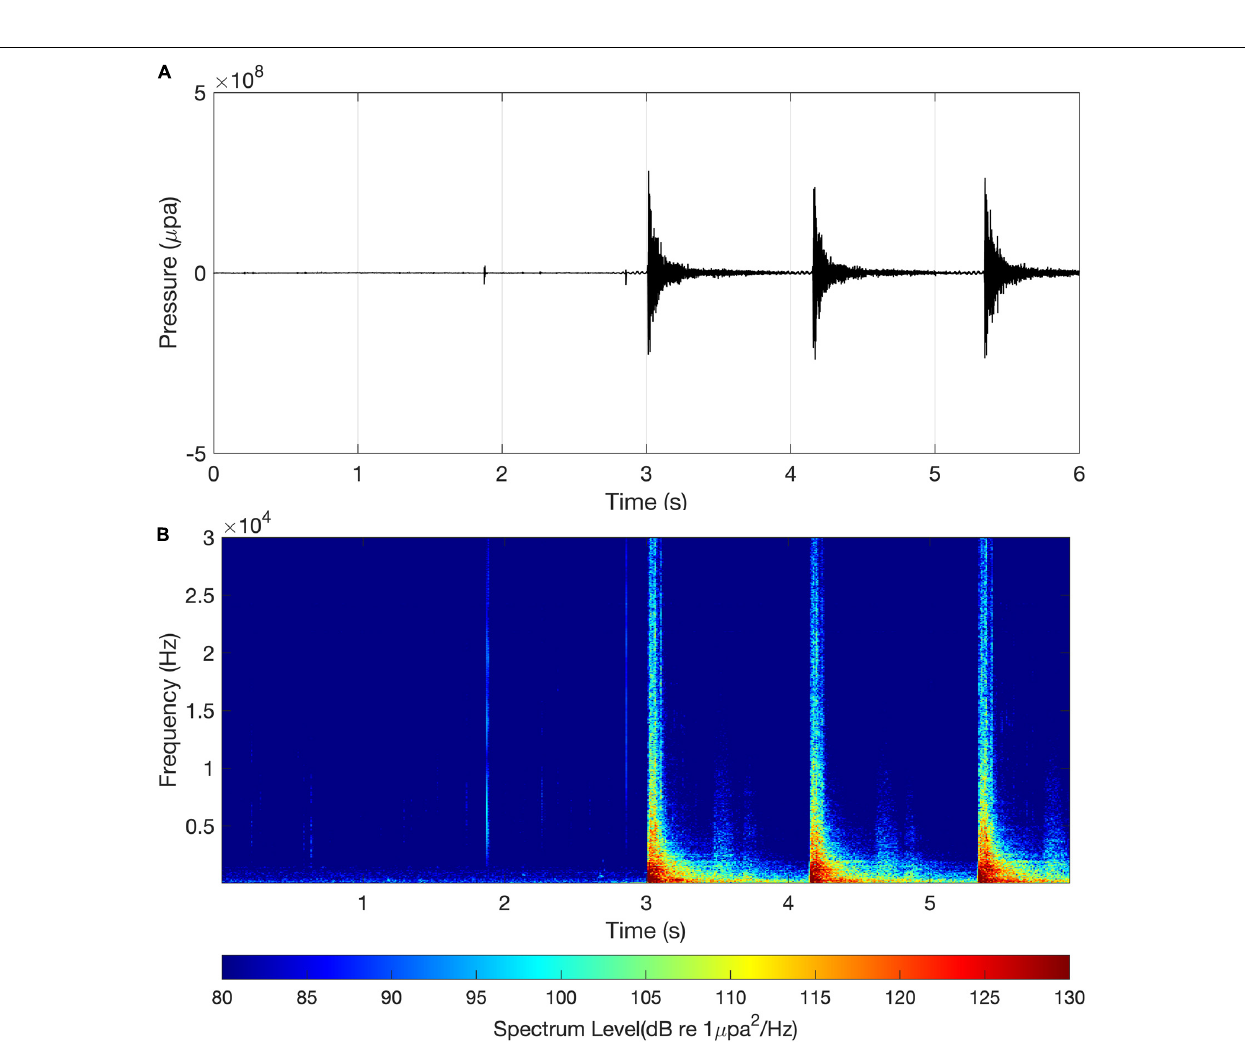
Frontiers in Marine Science |